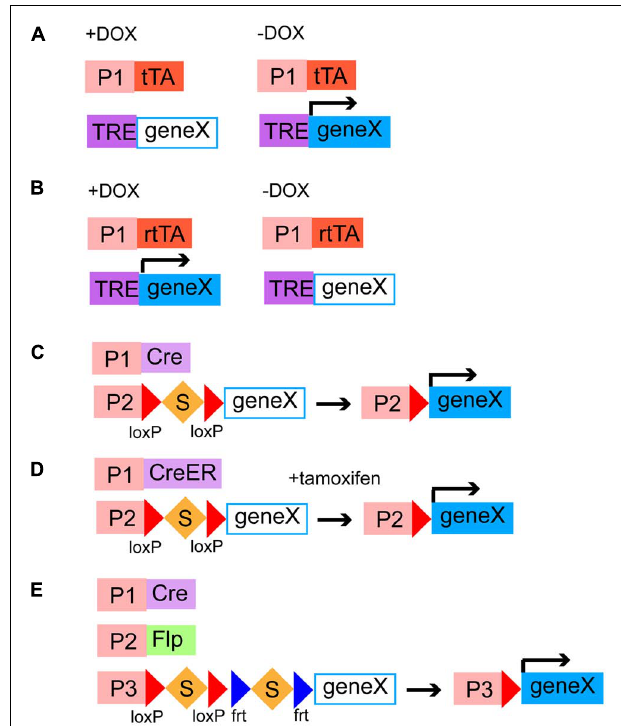
FIGURE 4 | Binary gene expression systems. (A,B) Transactivation-based systems of tetracycline-regulated transactivators and aTRE promoter. tTA or rtTA is expressed in specific cell populations by different genetic targeting strategies. tTA and rtTA drive the expression of a gene of interest downstream to aTRE promoter in the absence (A) and presence (B) of DOX, respectively. P1, cell type specific promoter; DOX, doxycycline, a tetracycline analog;TRE, a tetracycline-responsive element. (C–E) Site-specific DNA recombinase-based systems. (C,D) Cre or CreER is expressed in specific cell types by distinct genetic targeting strategies. Cre removes the transcriptional stop cassette and then a gene of interest is expressed under the control of a ubiquitous promoter (C) . CreER is activated by addition of tamoxien and then excises the stop cassette, leading to the expression of a gene of interest (D) . S, a transcriptional stop cassette; P1, a cell type specific promoter; P2, a ubiquitous promoter. (E) Intersectional strategy using a Cre/Flp-dependent dual responder line. Cre and Flp are expressed in distinct neuronal classes, which have partially overlapping population.The intersectional population that expresses both Cre and Flp can drive the expression of a gene of interest under the control of a ubiquitous promoter. P1 and P2, cell type specific promoters; P3, a ubiquitous promoter.